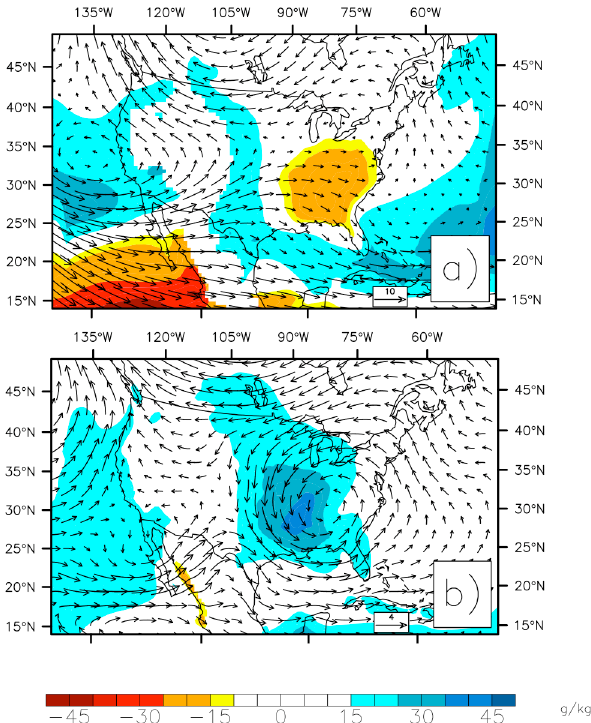
Fig. 10. NINO minus MODERN total column integrated moisture content subtracted from lower ( ∼ 850 to surface) integrated moisture isolating moisture content in the upper atmosphere (gkg − 1 ). (a) Upper integrated moisture for boreal summer, with the vectors rep- resenting mean wind (ms − 1 ) anomaly between NINO and MOD- ERN plotted at model level 3 ( ∼ 200mb). (b) Lower integrated moisture content ( ∼ 850 to surface) for boreal summer. Mean wind is plotted at model level 16 ( ∼ 850mb). The plots are statistically significant data at the 95% confidence